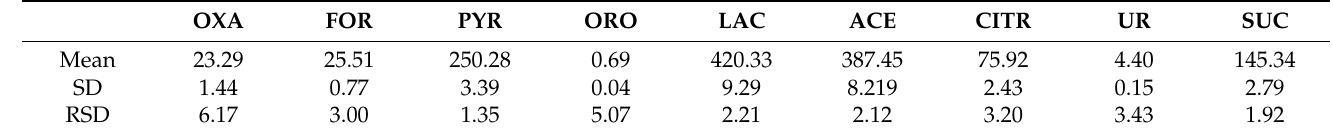
Table 2. Validation parameters of the RP HPLC method for organic acids (mg L − 1